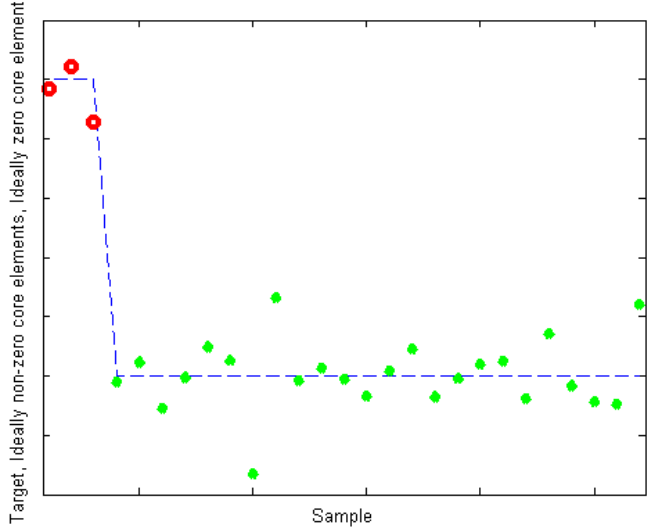
Figure 4. The red dot represent non-diagonal elements and the green dot represent diagonal elements, the degree of deviation of non-diagonal elements from 0 and the degree of deviation of diagonal elements from 1 are both smaller than those of other component number fitting cases. This result shows that the PARAFAC model with N = 3 is optimal.